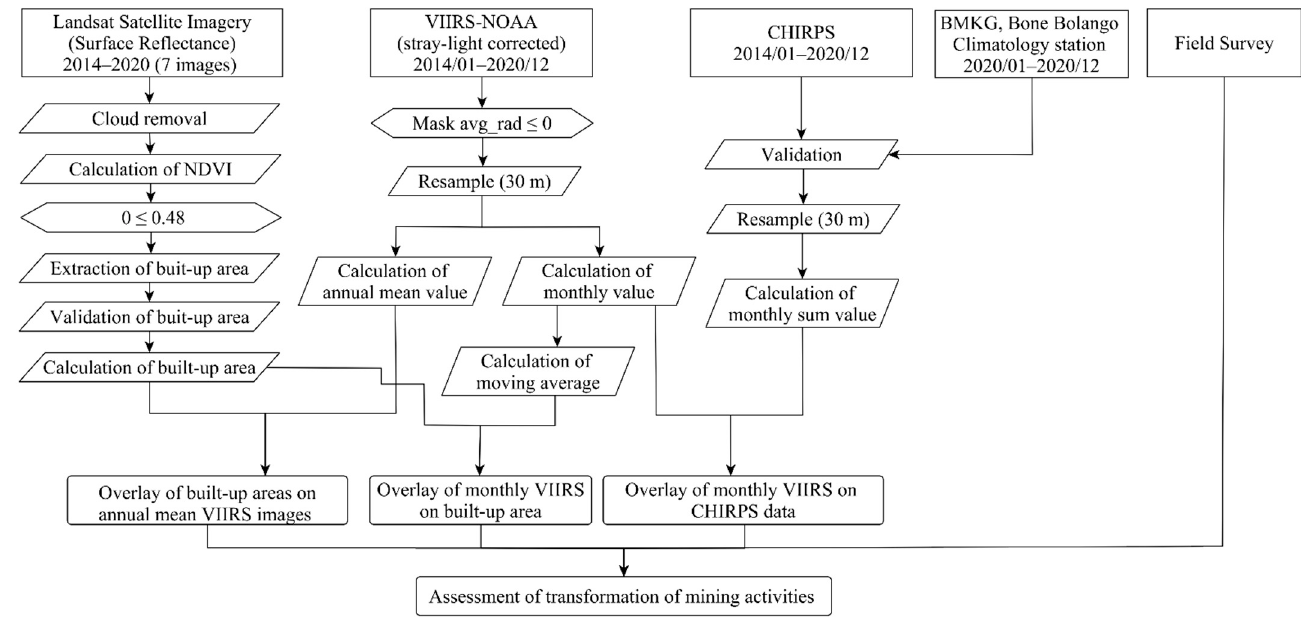
Figure 1. Overall Figure 1. Overall methodology.